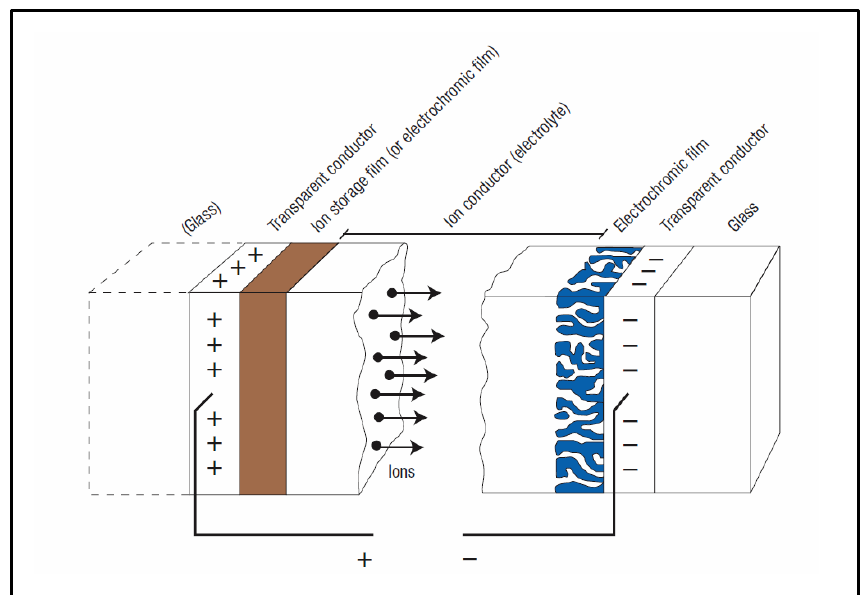
Figure 1. Schematic illustration of a layered electrochromic device (ECD) showing the movement of ions/electrons under an externally applied electric field. Reprinted by permission from [40], copyright (2006) Nature .